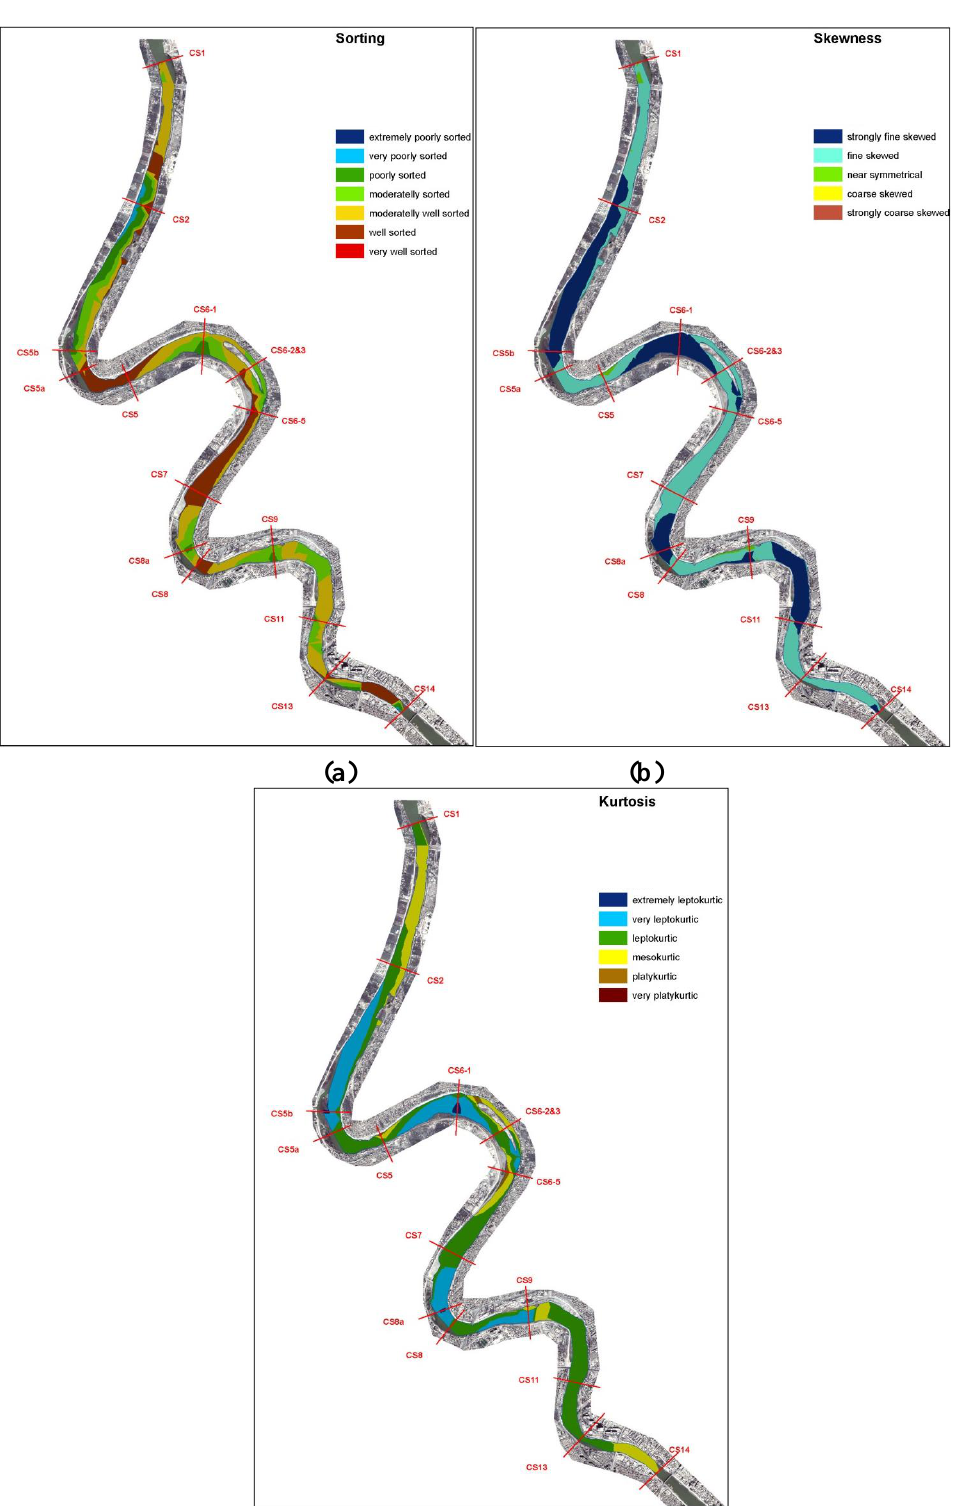
Figure 13. Distribution of the sediment (a) sorting; (b) skewness; (c) kurtosis of the bed of the Tigris River in Baghdad.